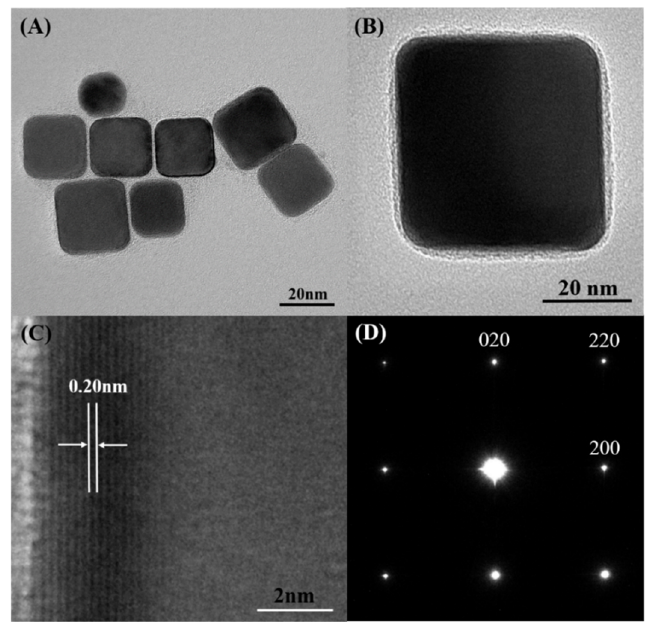
Figure 2. Low-( A ) and high-magnification ( B ) TEM images of the Pd nanocubes prepared using standard synthesis, ( C ) High-resolution TEM (HRTEM) image of an individual Pd nanocube, ( D ) Selected-area-electron diffraction (SAED) patterns of an individual Pd nanocube.